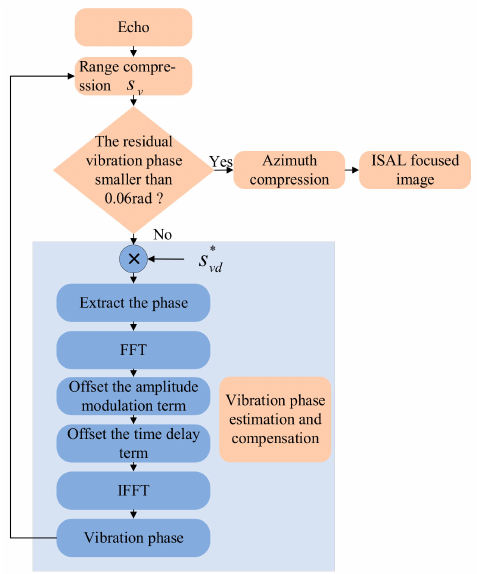
Figure 4. The flow chart of vibration phase estimation and compensation